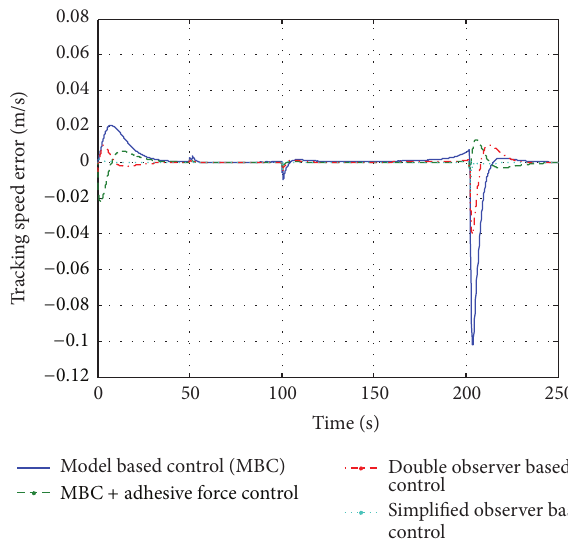
Figure 6: Performance of tracking speed